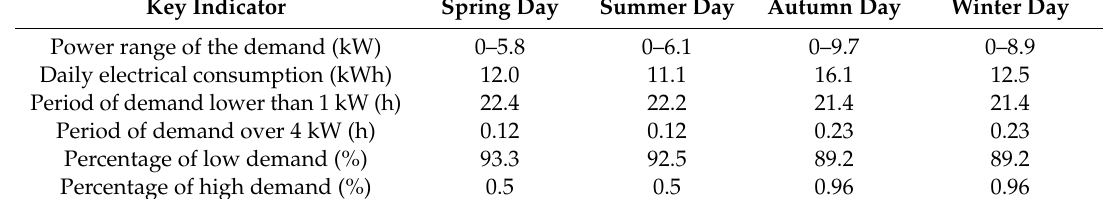
Table 1. Electricity demand on the four days in a UK house.